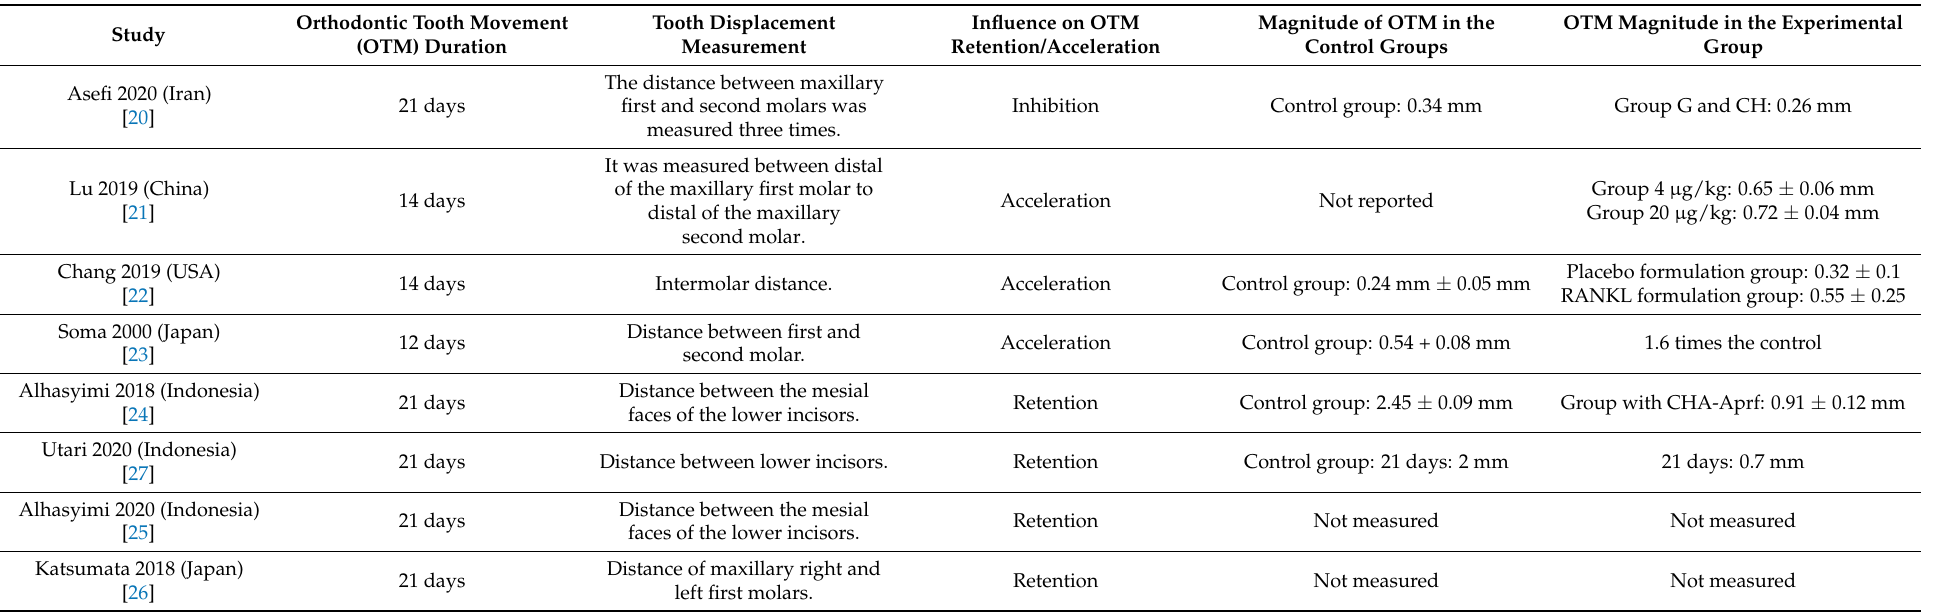
Table 2. Characteristics of tooth movement in the included